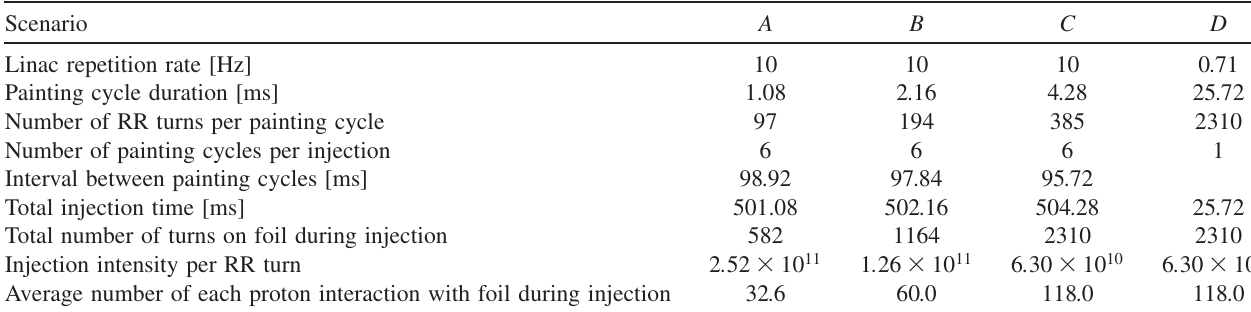
TABLE II. Painting injection scenarios studied for accumulation of 1 : 47 (cid:3) 10 14 protons per pulse (ppp) in the recycler